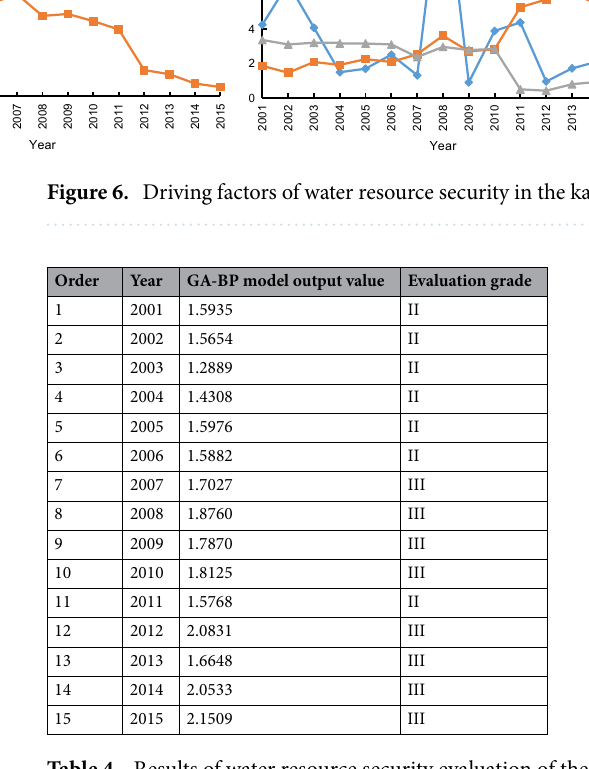
Table 4. Results of water resource security evaluation of the karst area based on the GA-BP model.